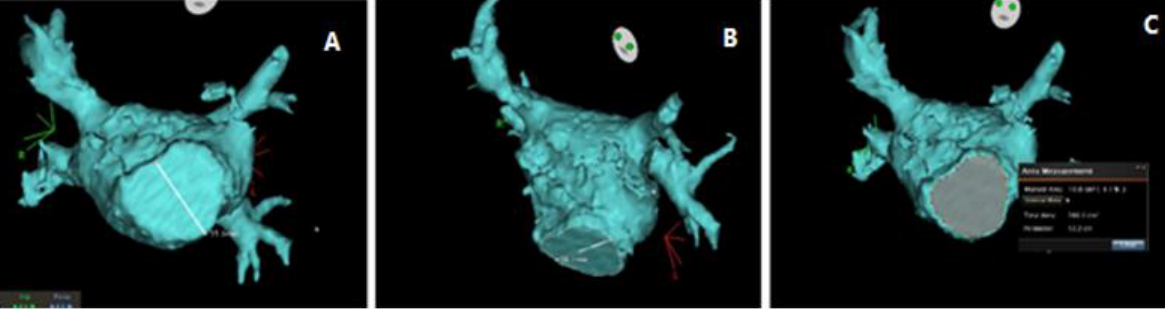
Figure 2. Assessment of mitral valve dimensions using MDCT. ( A ) White line shows measurement of the transverse diameter of the mitral annulus. ( B ) White line shows measurement of the longitudinal diameter of the mitral annulus. ( C ) Measurement of the mitral valve area and perimeter. The system calculates the perimeter and area based on the points defining the mitral annulus; perimeter = 12.2 cm, area = 10.8 cm 2 .